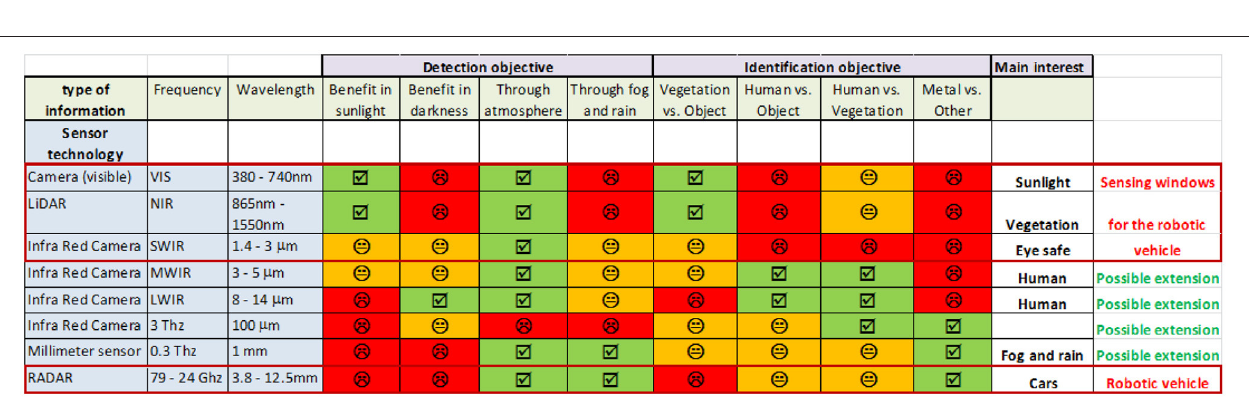
FIGURE 10 | Trends of perception technologies for CAVs. Green color means Yes , Red color means No , and Orange represents Maybe (Tschudi and Girardin, 2018).